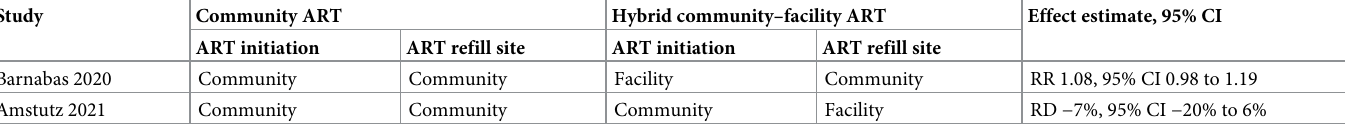
Table 5. Viral suppression among HIV-positive individuals at 12 months: Community ART initiation and refill versus community–facility hybrid initiation and refill strategies. Study Community